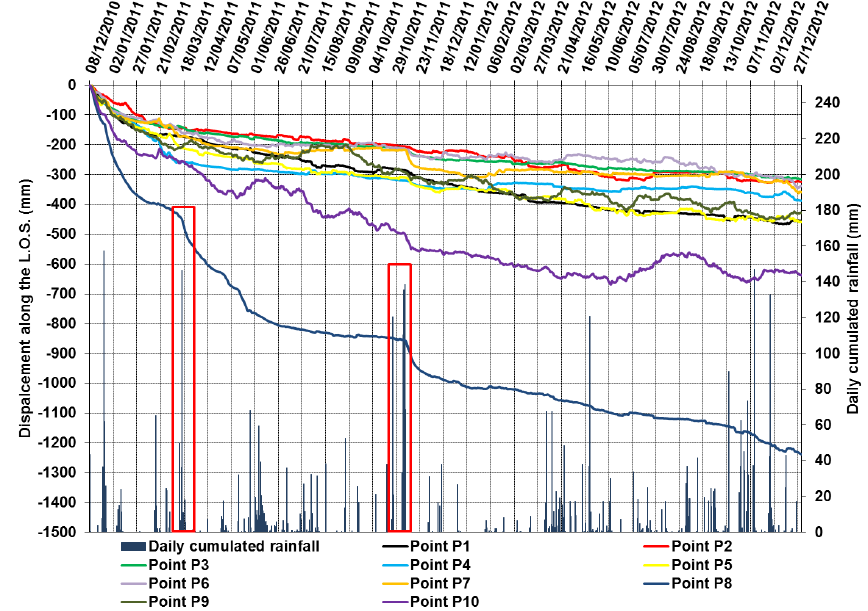
Figure 8. Selected measuring points displacement time series of the monitored scenario (red squares enhance Point 8